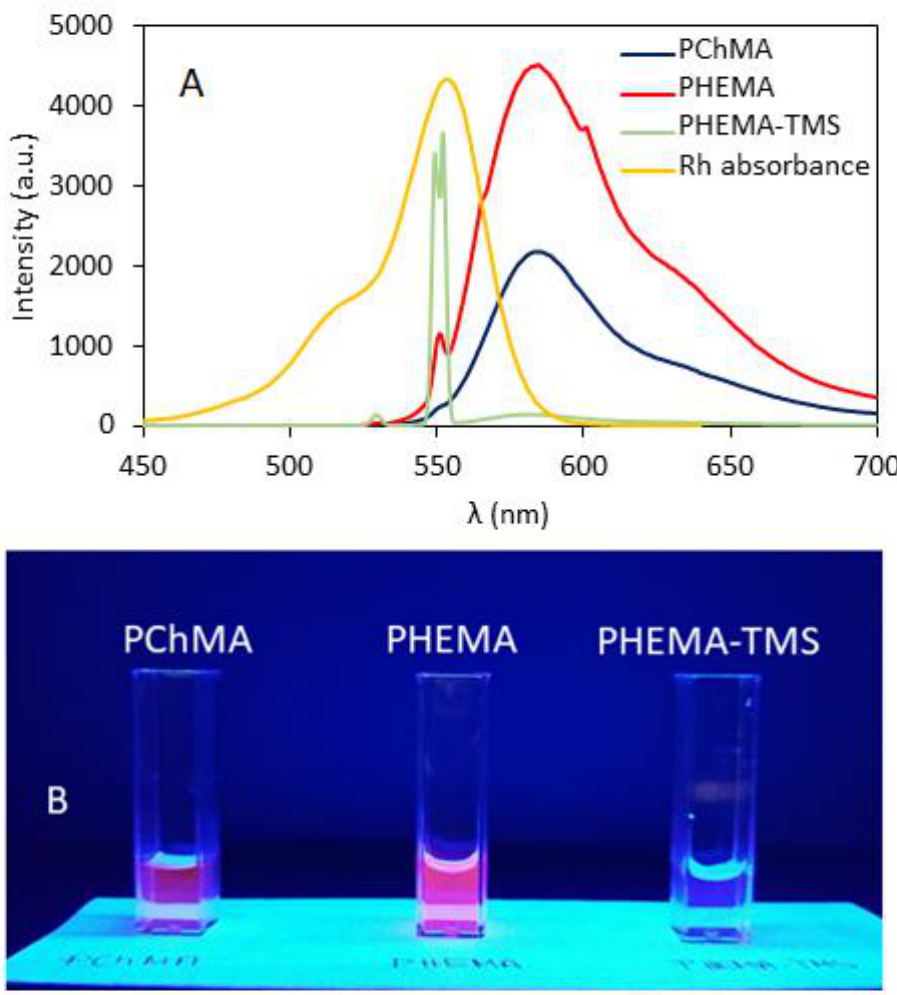
Figure 3. Normalized UV absorbance spectrum of rhodamine B and emission spectra of RhB-labeled polymers in aqueous solution (0.055 mg/mL) ( A ). Fluorescent glowing polymer solutions illuminated with UV lamp at 365 nm ( B ).